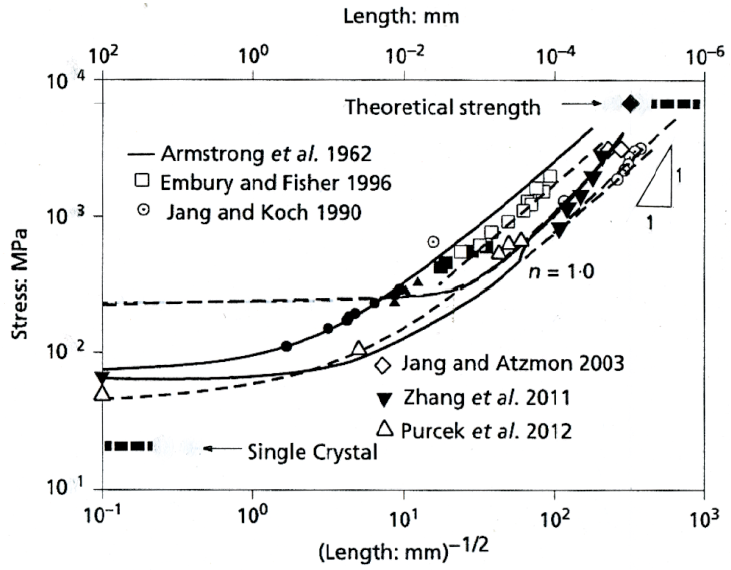
Figure 1. The strength dependence on crystal (grain) size for a number of iron and steel materials: mild steel; decarburized (Swedish) iron; pearlitic steel; ball-milled iron; interstitial-free (IF) iron; and, (patented) eutectoid and hypereutectoid steel wire.